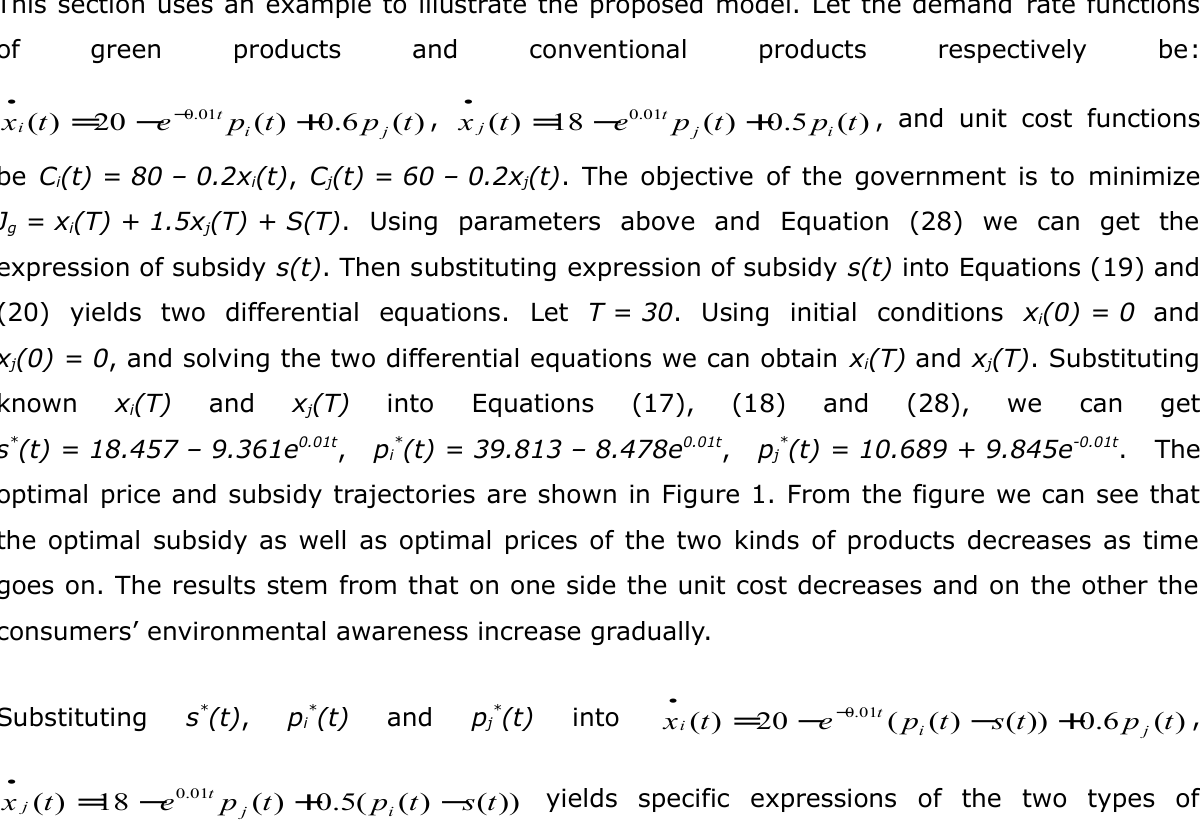
. Figure 2 shows how the demand rates of